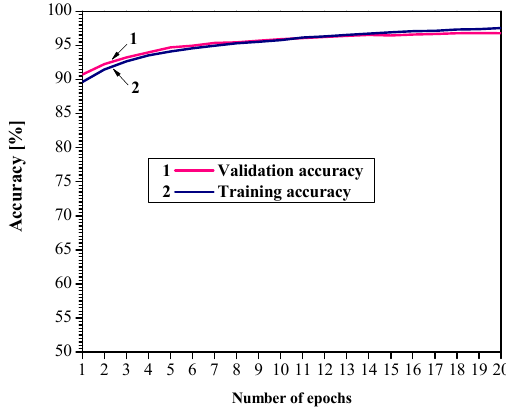
Figure 14. Learning curves for the considered multiplayer perceptron (MLP) neural network.